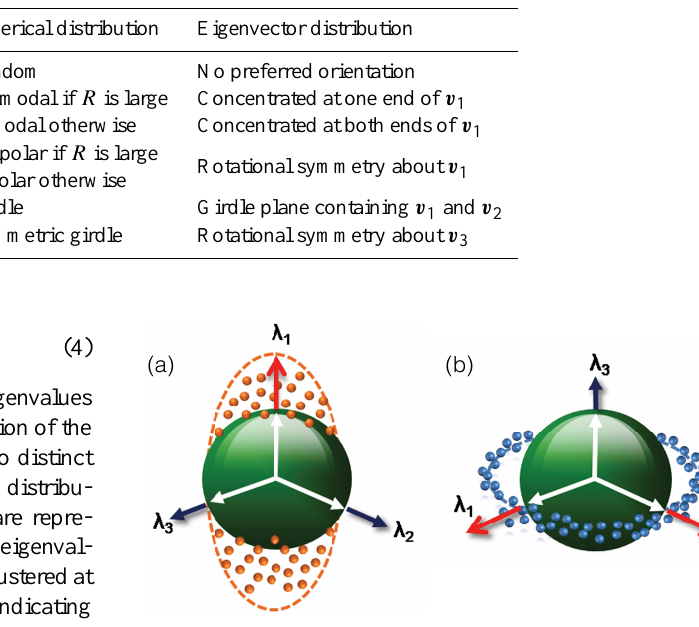
Table 1. Types of the spherical distributions based on eigenvalues and eigenvectors of the orientation matrix M . The order of eigenvalues is λ 1 >λ 2 >λ 3 . R is the length of the resultant vector. Modified from Mardia (1972).